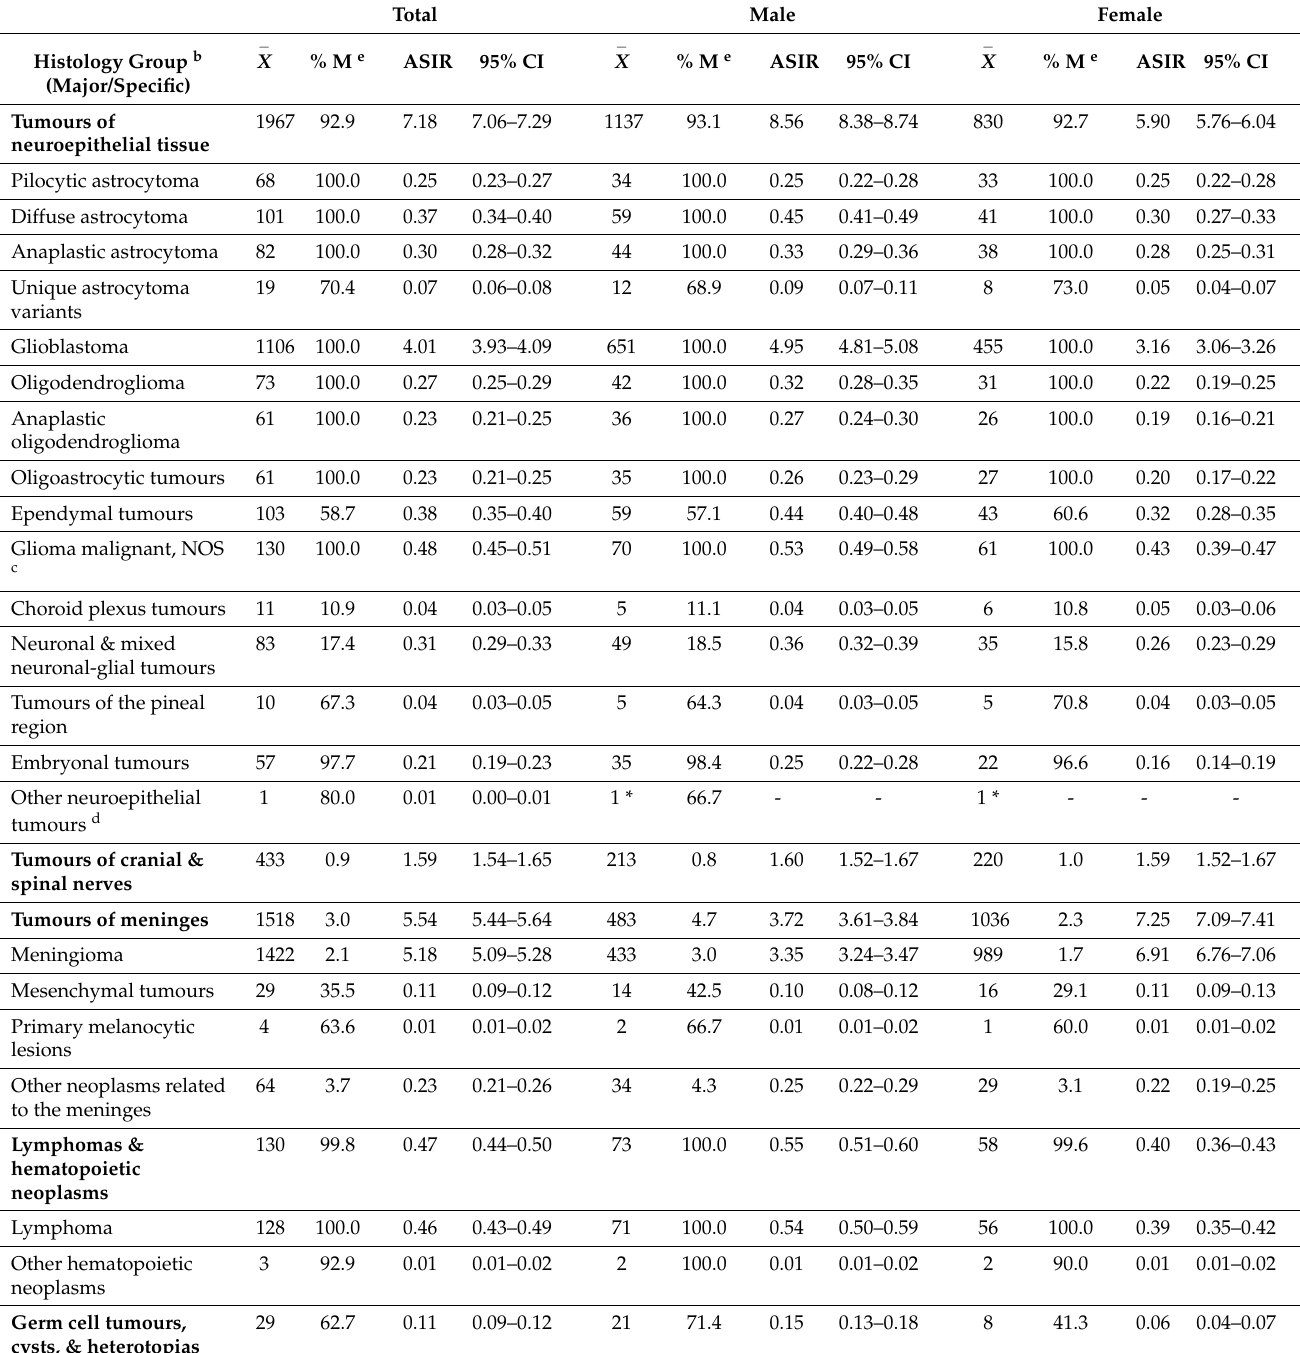
− X ), percent malignant e (% M), average annual age- Table 1. Average number of cases per year ( standardized incidence rates a (ASIRs, per 100,000 person-years) and associated 95% confidence intervals (CIs) for all primary central nervous system (CNS) tumours diagnosed between 2010–2017 in Canada (excluding Quebec) by histology and